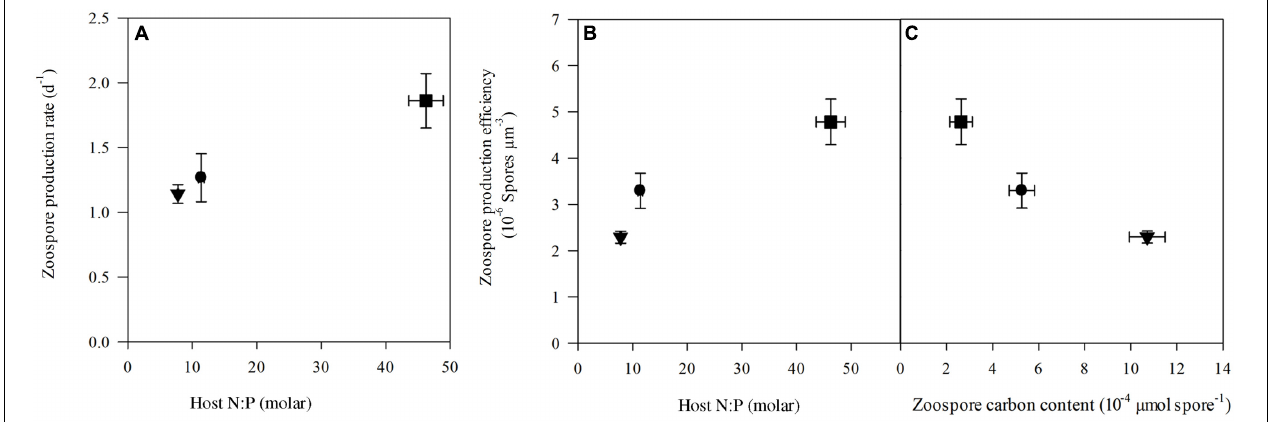
FIGURE 4 | Zoospore production rate (A) and production efficiency (B) plotted against host N:P and zoospore carbon content (C) in the control (circle), low N:P (triangle) and high N:P (square) treatments. Symbols represent mean ± standard error ( n = 4).